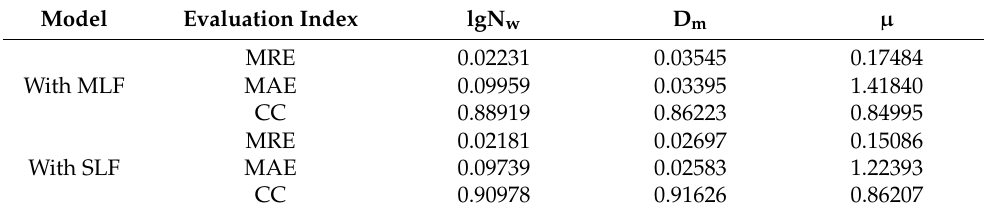
Table 5. The 12-min prediction evaluation results of stratiform clouds.